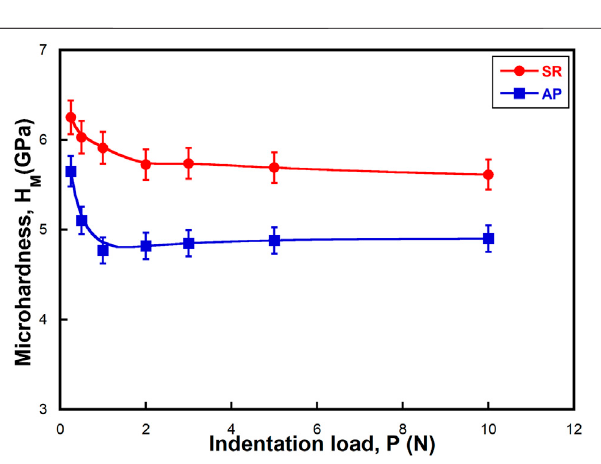
FIGURE 7 | Plot showing the dependence of microhardness, H m , on maximum indentation load, P max , for the SR and AP NGs.